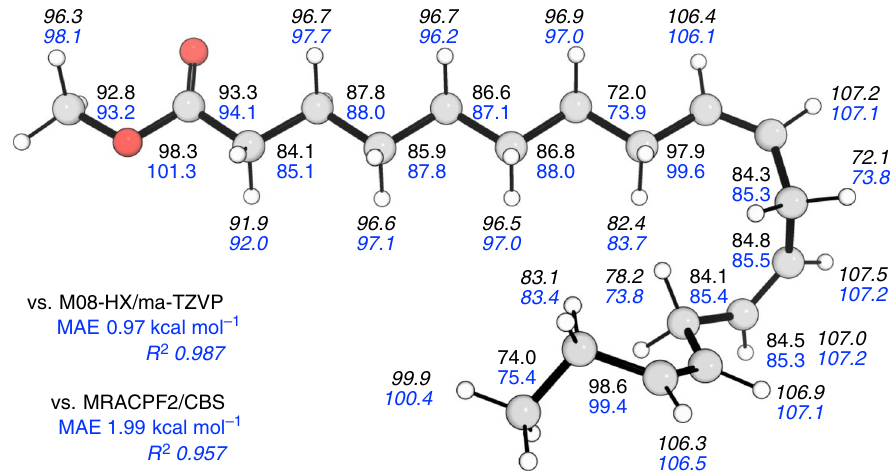
Fig. 6 Applying the ML approach to BDE prediction in a large organic molecule. Comparison of BDE values (kcal mol − 1 ) of the C – C, C – O, and C – H (italicized) bonds in methyl linolenate. ML values are in blue and M08-HX/ma-TZVP values are